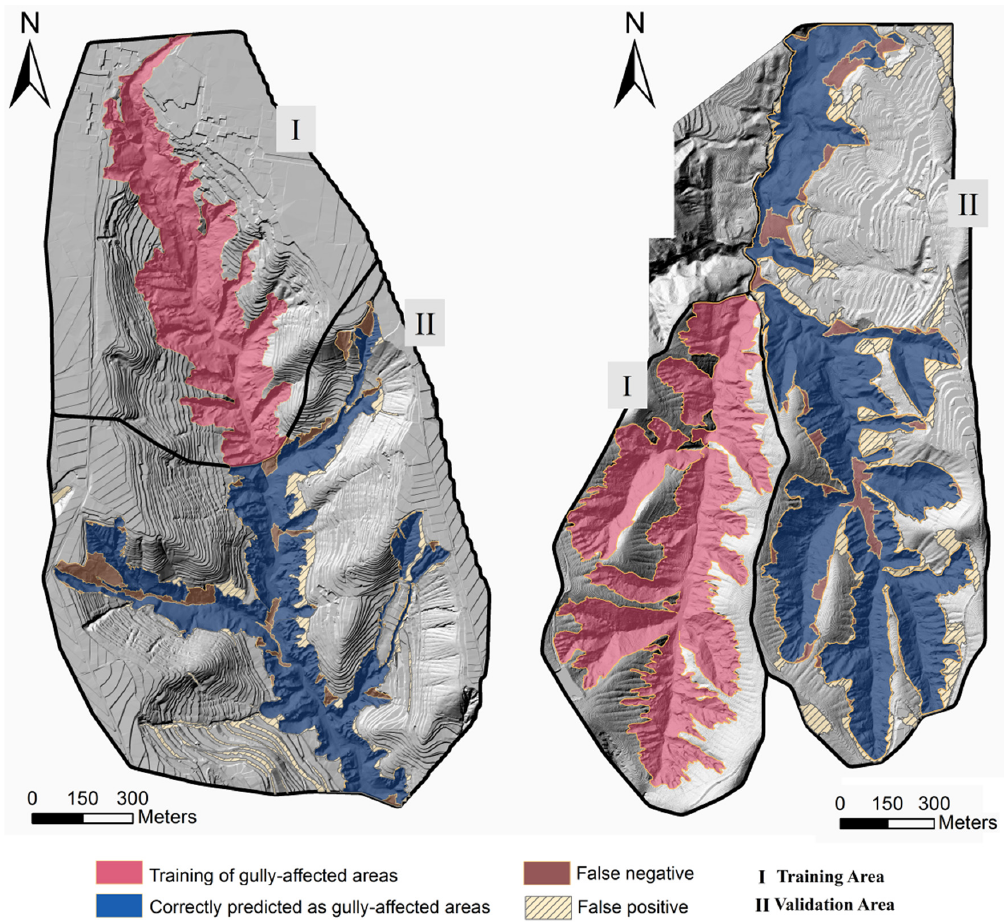
Figure 11. Detected gully-affected areas in: Changwu ( left ); and Ansai ( right ).